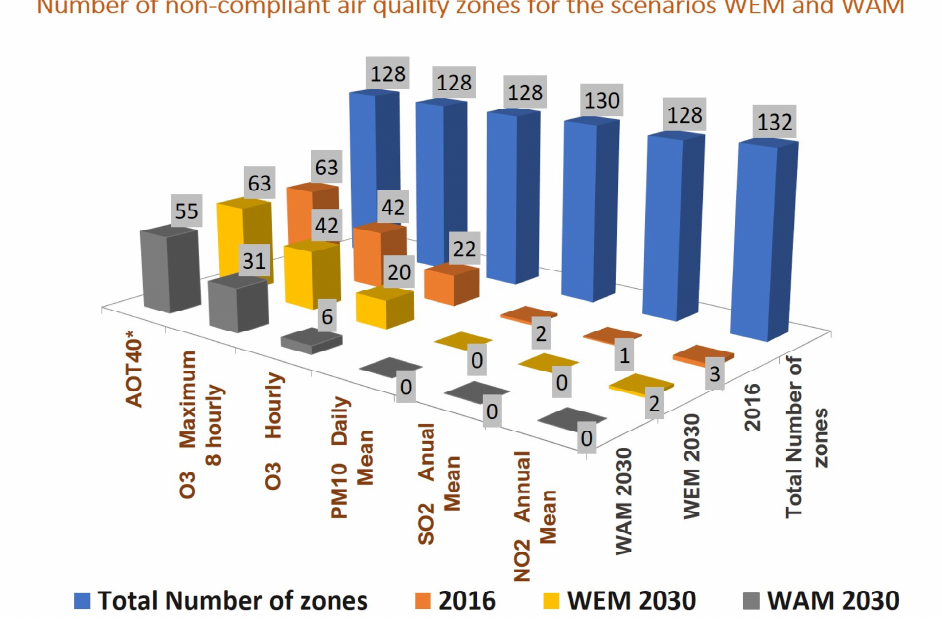
Figure 3. Number of non-compliant air quality zones for the base scenario (2016) and the WEM and WAM scenarios for